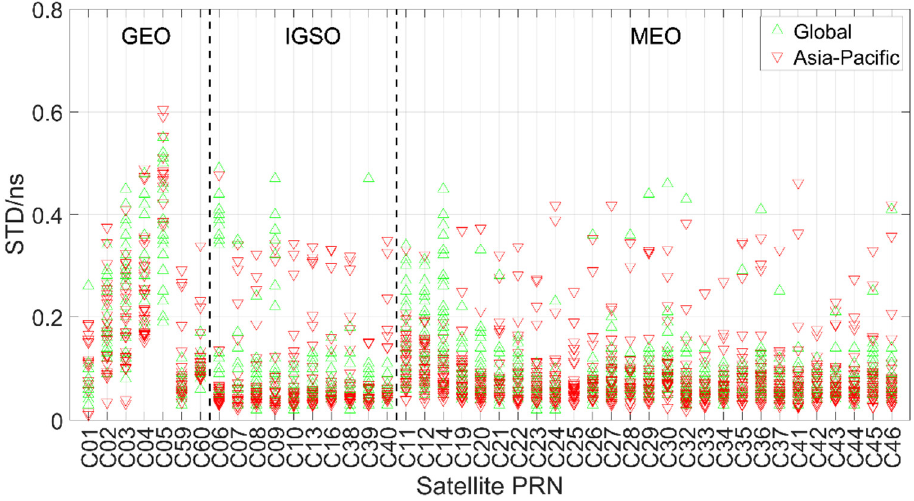
Figure 3. Daily accuracy of BDS clock offset in Global (green triangle) and Asia-Pacific (red triangle).